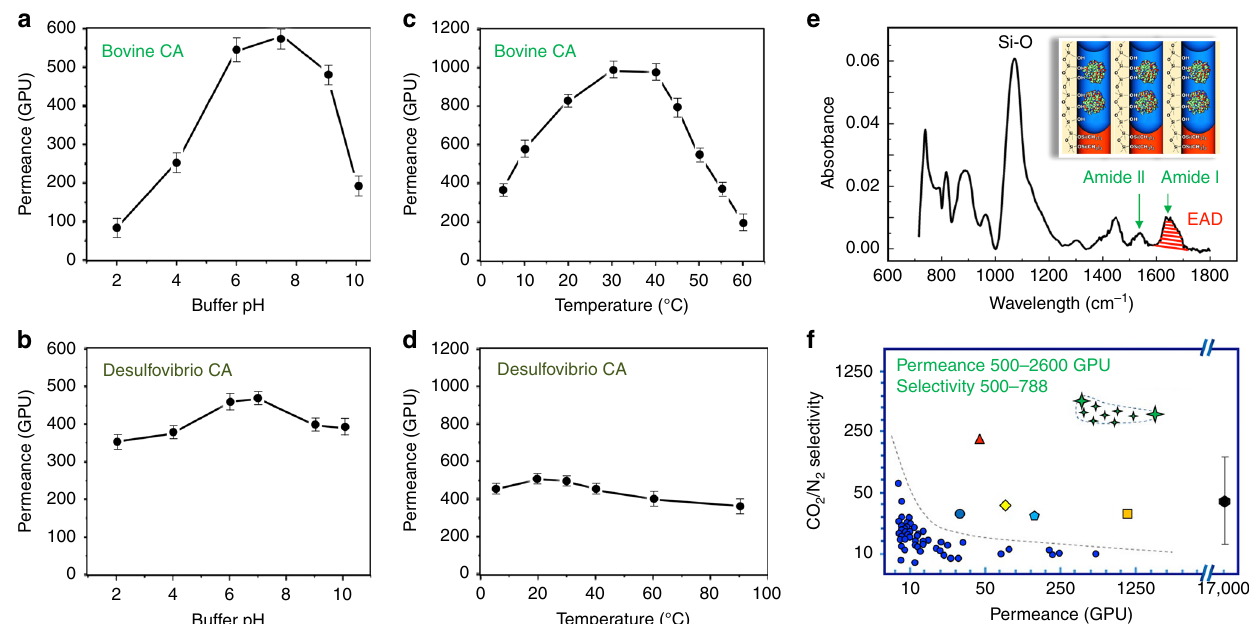
Fig. 7 CO 2 separation applications of the enzymatic liquid membrane. a , b Comparison of the CO 2 permeance of Bovine CA and Desulfovibrio vulgaris CA enzymatic liquid membranes as a function of the pH. c , d Comparison of the CO 2 permeance of Bovine CA and Desulfovibrio vulgaris CA enzymatic liquid membranes as a function of the temperature. e FTIR spectrum of the enzymatic liquid membrane indicating an effective areal density (EAD) of 8.0 × 10 11 CA cm – 2 that is consistent with the loading of two CA enzymes per nanopore. f Selectivity vs. permeance plot (log 5 scale) of the enzymatic liquid membrane compared with various membranes. The green stars are performance range for our ultra-thin enzymatic liquid membrane; the red triangle is the performance for the Carbozyme CA membrane 19; the blue dots, the ocean blue circle, the yellow prism, the light blue pentagon, the orange square, and the black hexagon are CO 2 membrane performance data respectively from references 7,49 – 53,10 . The selectivity of the ZSM-5 membranes (black hexagon) 10 increases from 17 to 210 as the temperature decreases from 37 to − 43 °C. Error bars represent 95% con fi dence intervals for experiments performed